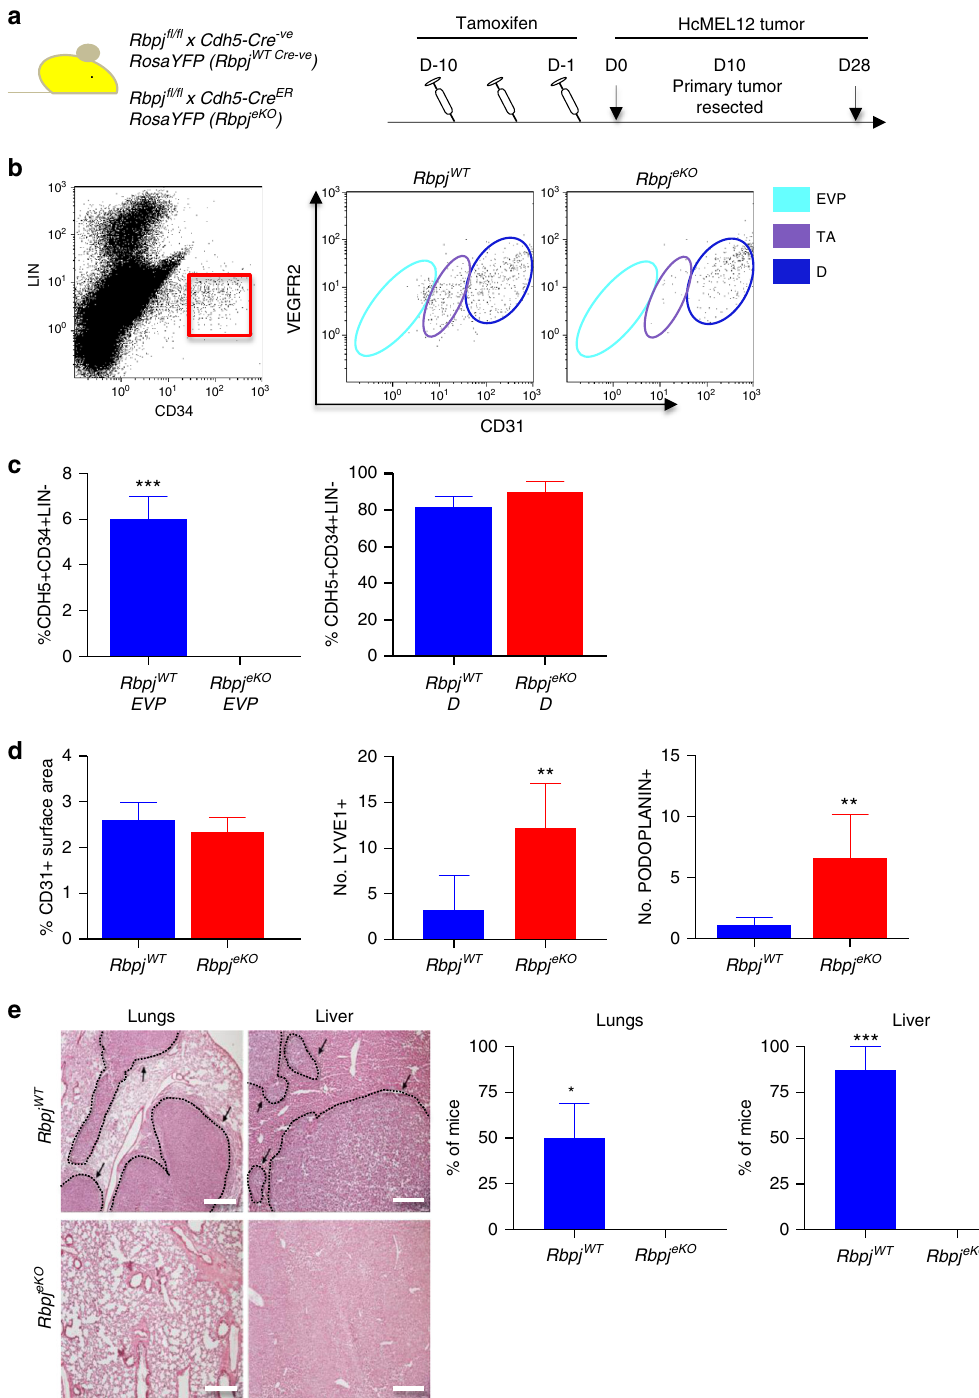
Fig. 7 Vascular-speci fi c knock-out of Rbpj results in EVP depletion and reduced metastasis. a Schematic diagram of the Rbpj fl / fl /Cdh5-Cre ER RosaYFP ( Rbpj eKO ) and Rbpj fl / fl RosaYFP ( Rbpj WT-Cre Negative ) lineage tracing model employed, with mice receiving tamoxifen (Tam) for 10 consecutive days prior to tumor inoculation with metastatic HcMEL12 melanoma cells injected at day 0 (D0). Tumors were harvested at D28 ( n = 5). b , c Flow cytometry plots demonstrate that EVP cells are entirely absent from Rbpj eKO mice compared to Rbpj WT (*** p < 0.001 vs Rbpj eKO ; Mann – Whitney T -Test). No change was observed in the percentage of D cells present from either group. d No difference was observed in CD31 + vessel surface area between the groups. Signi fi cantly more Lyve1 + and Podoplanin + vessels were observed in the Rbpj eKO mice compared to Rbpj WT (** p < 0.01 vs Rbpj WT ; Mann – Whitney T -Test). e Histological analysis of lungs and liver showed vast metastatic nodules in the Rbpj WT compared to no visible nodules in the Rbpj eKO mice (* p < 0.05; *** p < 0.001 vs Rbpj eKO , Mann – Whitney T -Test). Results presented as mean ± SEM. Scale bar represents 150 μ m. EVP endovascular progenitor, TA